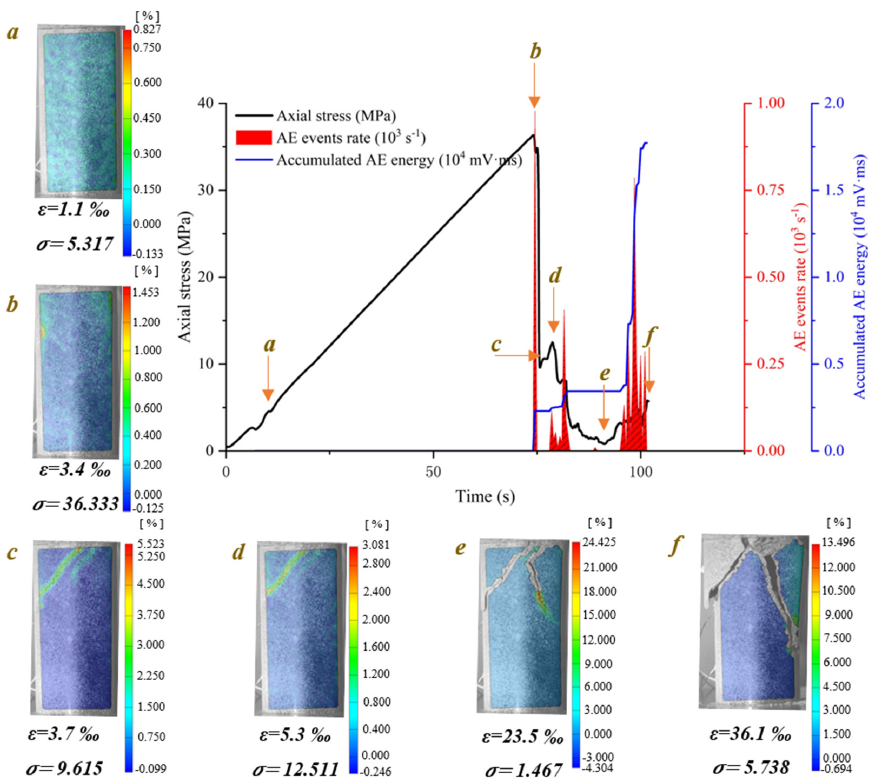
Figure 7. Crack evolution process of water-saturated phyllite with 45° foliation angle (S-W-45°).